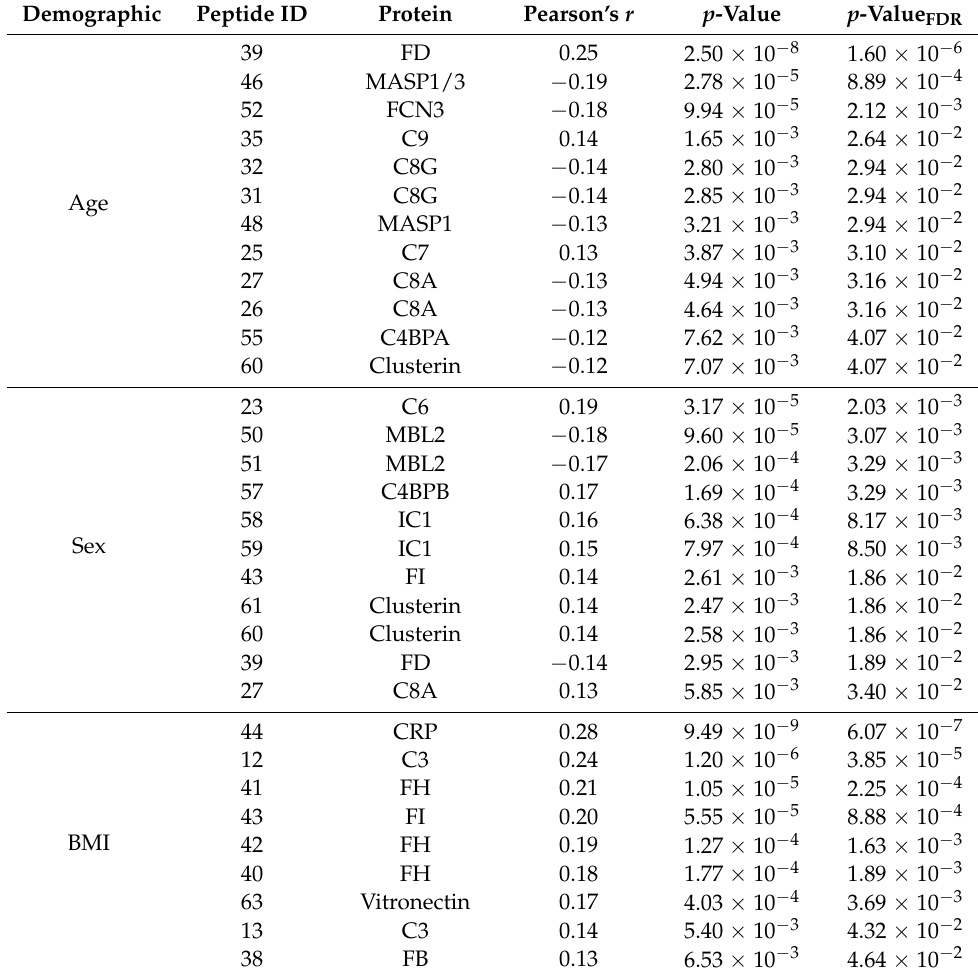
Table 1. Association of demographic factors with complement peptide levels. Pearson correlation was computed for each demographic factor, and the significantly associated protein peptides are shown. Full list of Pearson correlations to age, sex, smoking and BMI can be found in Supplementary Tables